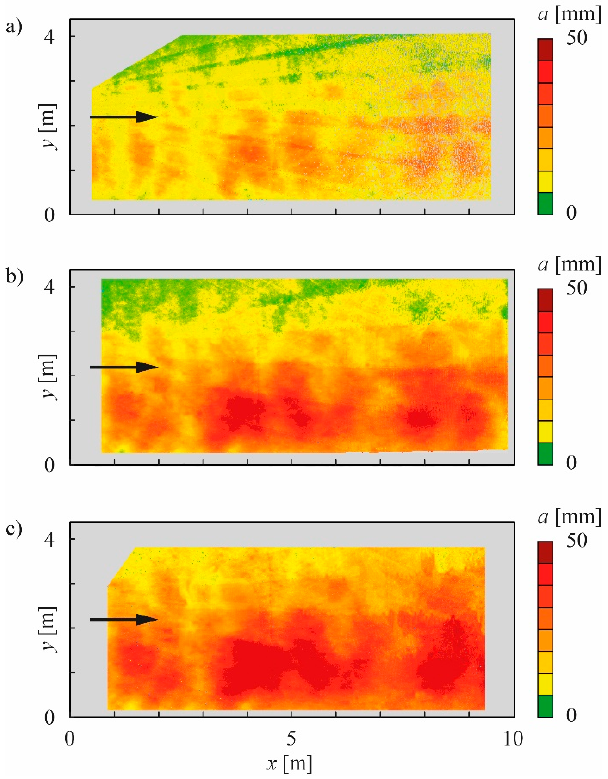
Figure 5. High-resolution abrasion maps of the 10 m long high-strength concrete test field C1 installed at test location 1 in Pfaffensprung SBT after ( a ) one, ( b ) two and ( c ) four operational years (the grey colored areas could not be scanned due to ground water drainage installation).